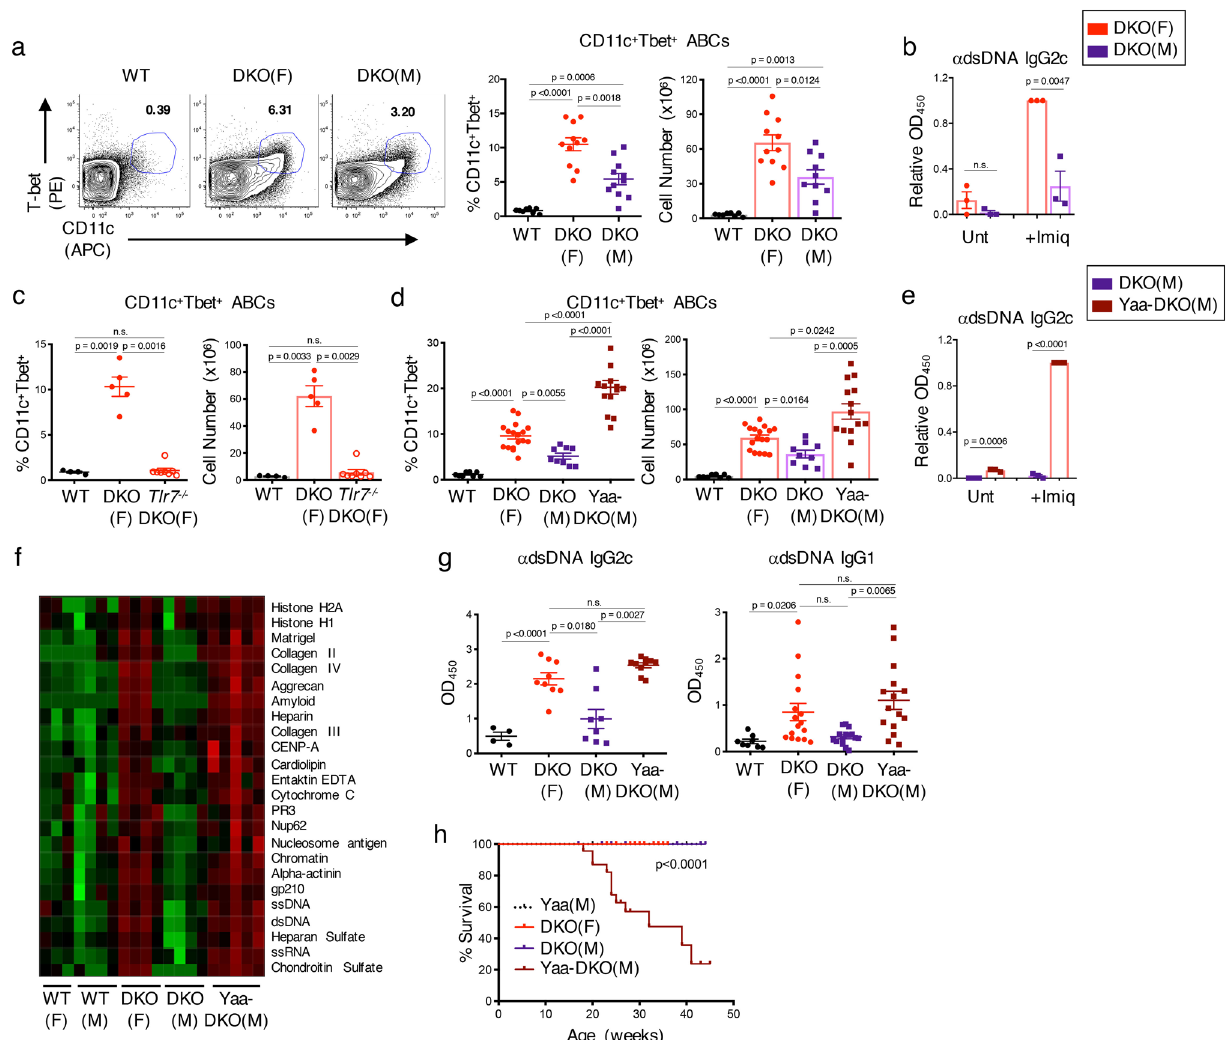
Fig. 1 TLR7 controls sex-speci fi c differences in ABC formation and function. a Representative FACS plots and quanti fi cations of CD11c + Tbet + ABCs (gated on B220 + ) from spleens of aged (24 + wk) female C57BL/6 (WT) (black circles) , female DKO (F) (red circles), and male DKO (M) mice (purple squares). Data shows mean ± SEM; n = 8 for WT, n = 11 for DKO(F), n = 10 for DKO(M) over 8 independent experiments; p -value by Brown – Forsythe and Welch ANOVA followed by Games – Howell ’ s test for multiple comparisons. b Pooled ELISA data for anti-dsDNA IgG2c antibodies from supernatants of sorted ABCs (B220 + CD19 + CD11c + CD11b + ) from spleens of aged (24 + wk) DKO(F) and DKO(M) mice after culturing with Imiquimod for 7d. Data shows mean ± SEM; n = 3; p -value by unpaired two-tailed t -tests. c Quanti fi cations of CD11c + Tbet + ABCs from the spleens of aged (24 + wk) female WT, DKO(F), and female Tlr7 -de fi cient DKO ( Tlr7 − / − .DKO(F)) mice (red open circles). Data show mean ± SEM; n = 4 for WT, n = 5 for DKO(F), n = 8 for Tlr7 − / − .DKO (F) mice over 4 independent experiments; p -value by Brown – Forsythe and Welch ANOVA followed by Games – Howell ’ s test for multiple comparisons. d Quanti fi cations of CD11c + Tbet + ABCs (gated on B220 + ) from the spleens of aged (24 + wk) WT, DKO(F), DKO(M), and male Yaa-DKO(M) mice (maroon squares). Data shows mean ± SEM; n = 8 for WT, n = 17 for DKO(F), n = 9 for DKO(M), n = 14 for Yaa-DKO(M) over 8 independent experiments; p -value by Brown – Forsythe and Welch ANOVA followed by Games – Howell ’ s test for multiple comparisons. e Pooled ELISA data for anti- dsDNA IgG2c antibodies from supernatants of sorted ABCs from aged (24 + wk) DKO(M) or Yaa-DKO(M) mice after culturing with Imiquimod for 7d. Data shows mean ± SEM; n = 3; p -value by unpaired two-tailed t -tests. f Autoantigen microarray showing the relative autoantibody levels in the serum of aged (24 + wk) female WT (F), male WT (M), DKO(F), DKO(M), and Yaa-DKO(M) mice; n = 3 for WT(F), n = 4 for WT(M), DKO(F), and DKO(M), n = 5 for Yaa-DKO(M). g Pooled ELISA data for anti-dsDNA IgG2c and IgG1 in the serum from the indicated aged (24 + wk) mice. Data shows mean ± SEM; for anti-dsDNA IgG2c, n = 4 for WT, n = 9 for DKO(F), n = 8 for DKO(M), n = 10 for Yaa-DKO(M); for anti-dsDNA IgG1, n = 8 for WT, n = 16 for DKO(F), n = 14 for DKO(M); n = 15 for Yaa-DKO(M); p -value by Brown – Forsythe and Welch ANOVA followed by Games – Howell ’ s test for multiple comparisons. h Plot showing survival rate of Yaa control, DKO(F), DKO(M), and Yaa-DKO(M) mice across 45 weeks. Data represents a cohort of 14 Yaa control, 16 DKO (F), 9 DKO(M), and 31 Yaa-DKO(M) mice; p -value by Mantel – Cox primarily observed in the spleen but not in the BM (Fig. 2c;